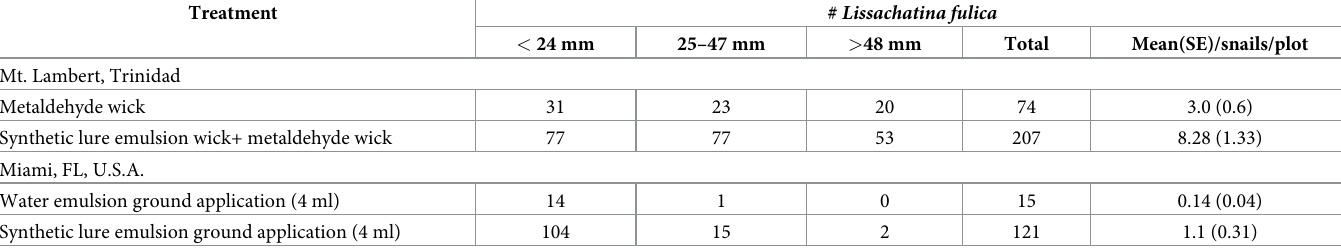
Table 6. The total number and size range of giant African snails ( Lissachatina fulic) found 25 cm from Petri dishes with a cotton wick saturated with liquid metal- dehyde or a wick with 0.2% synthetic papaya lure in a 1:1:0.2 emulsion of water, canola oil, and Tween in a field bioassay at Mt. Lambert, Trinidad (n = 25), or 15 cm from 4 ml ground applications of the same blend and a water emulsion control 12 h after application of liquid metaldehyde in Miami, FL, U.S.A. (n =